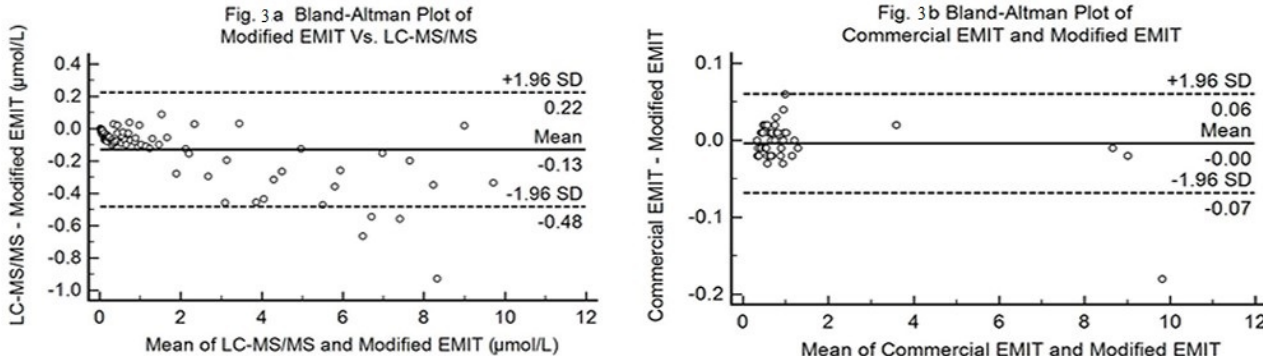
FIGURE 3a - Bland-Altman plot of Modified EMIT and LC-MS/MS measurements. It displays a scatter diagram of the differences between two measurements (Y-axis) against the averages of them (X-axis). Three horizontal lines represent mean,